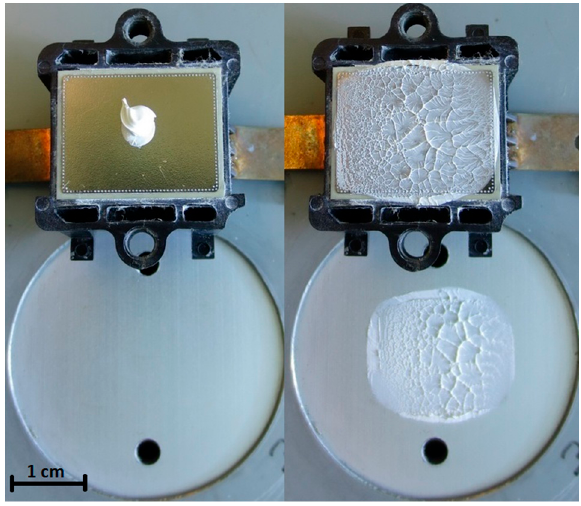
Figure 3. Image of the actual photovoltaic cells with the dispersed thermal interface material.